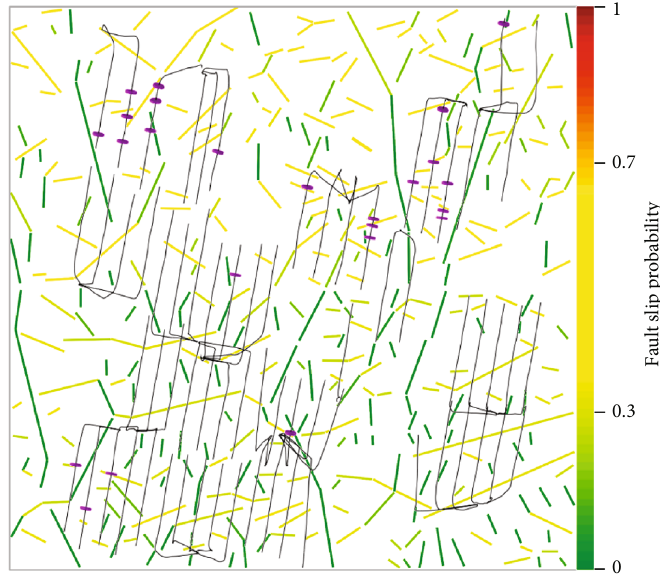
Figure 18: The slip probability of faults under reduced pumping rate in the Ning209 block.